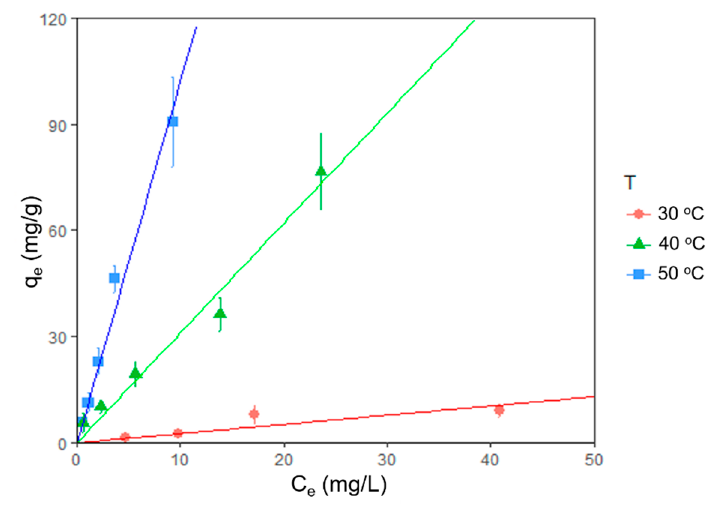
Figure 3. Isotherm plots showing temperature effect on dye removal. Final adsorption (q e ) is plotted vs. final concentration (C e ) at three different temperatures (30, 40, and 50 °C). Points with error bars represent measurements with the experimental error. Lines represent fit with the theoretical model linear isotherms.